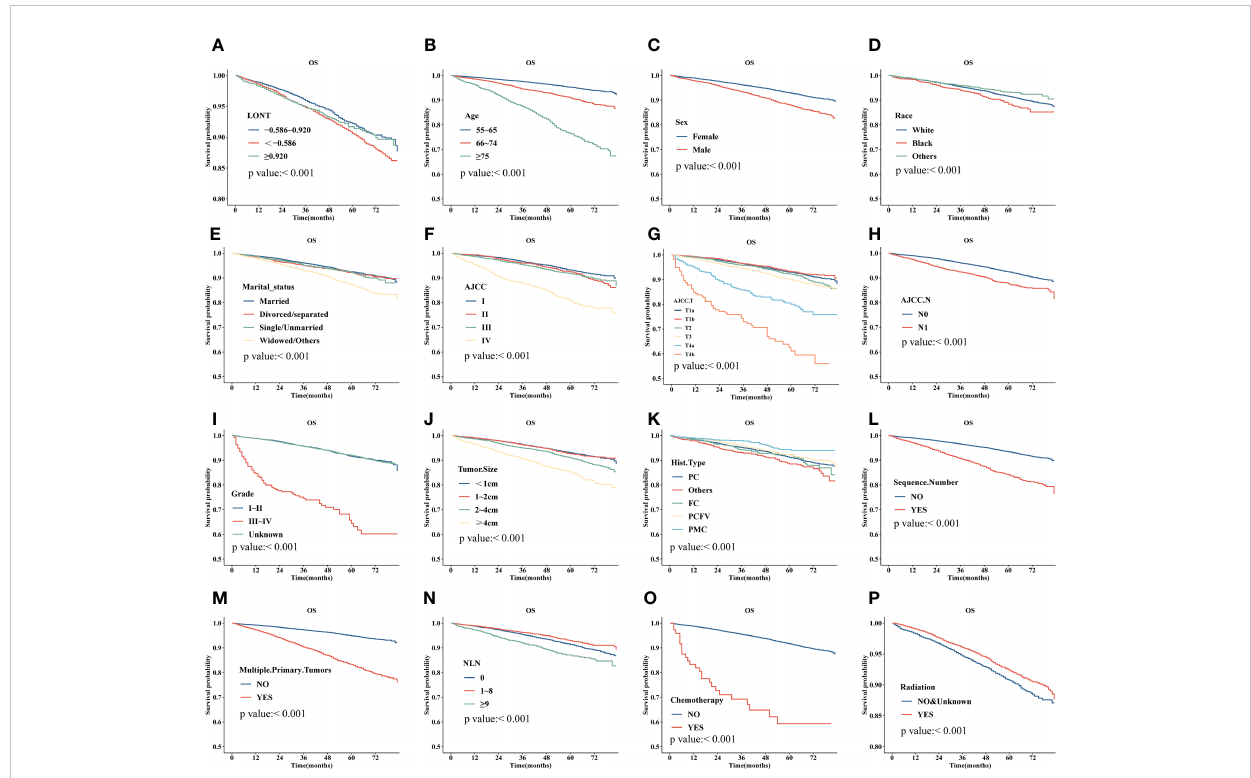
FIGURE 1 Kaplan – Meier plot for overall survival (OS) for LONT (A) , age (B) , sex (C) , ethnicity (D) , marital status (E) , stage (based on AJCC system) (F) , T stage (based on AJCC system) (G) , N (based on AJCC system) (H) , tumor grade (I) , tumor diameter (J) , histology type (K) , sequence number (L) , multiple primary tumors (M) , NLNs (N) , chemotherapy (O) , and radiotherapy (P) of patients with differentiated thyroid cancer without metastases aged 55 years and